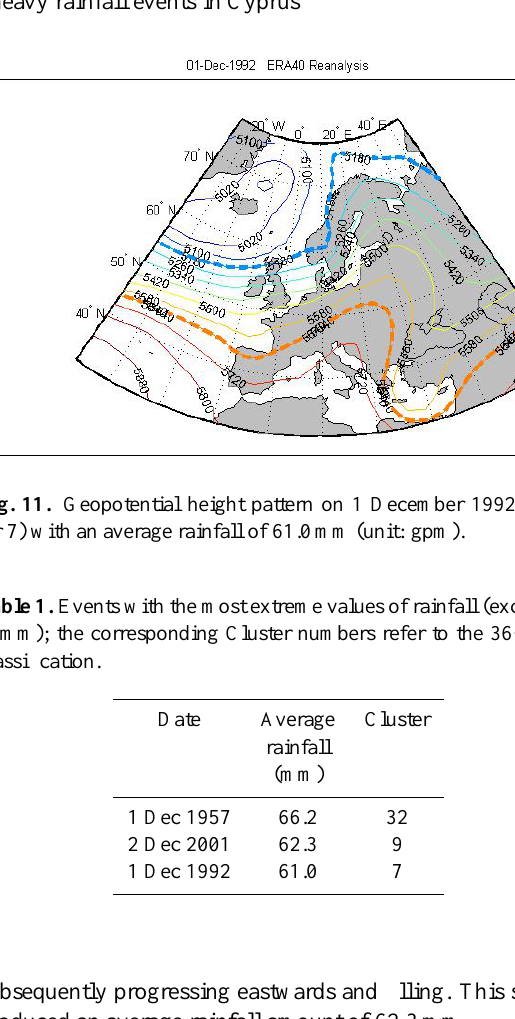
Fig. 10. Geopotential height pattern on 2 December 2001 (Cluster 9) with an average rainfall of 62.3mm (unit: gpm).